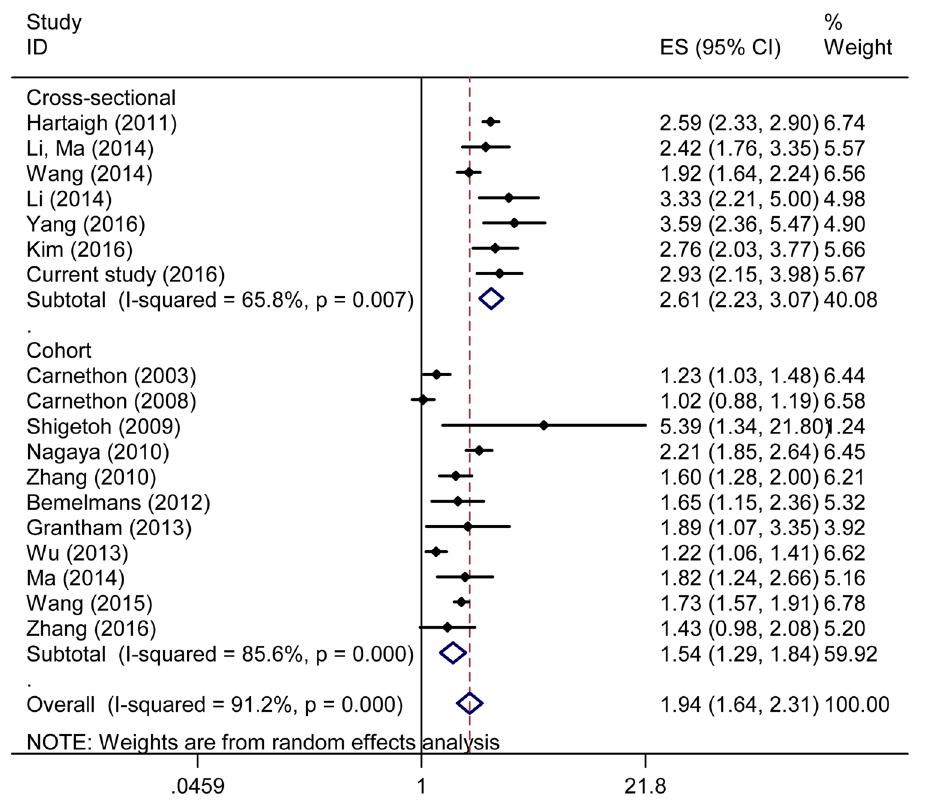
Figure 1. Forest plot of resting heart rate and diabetes risk for the selected